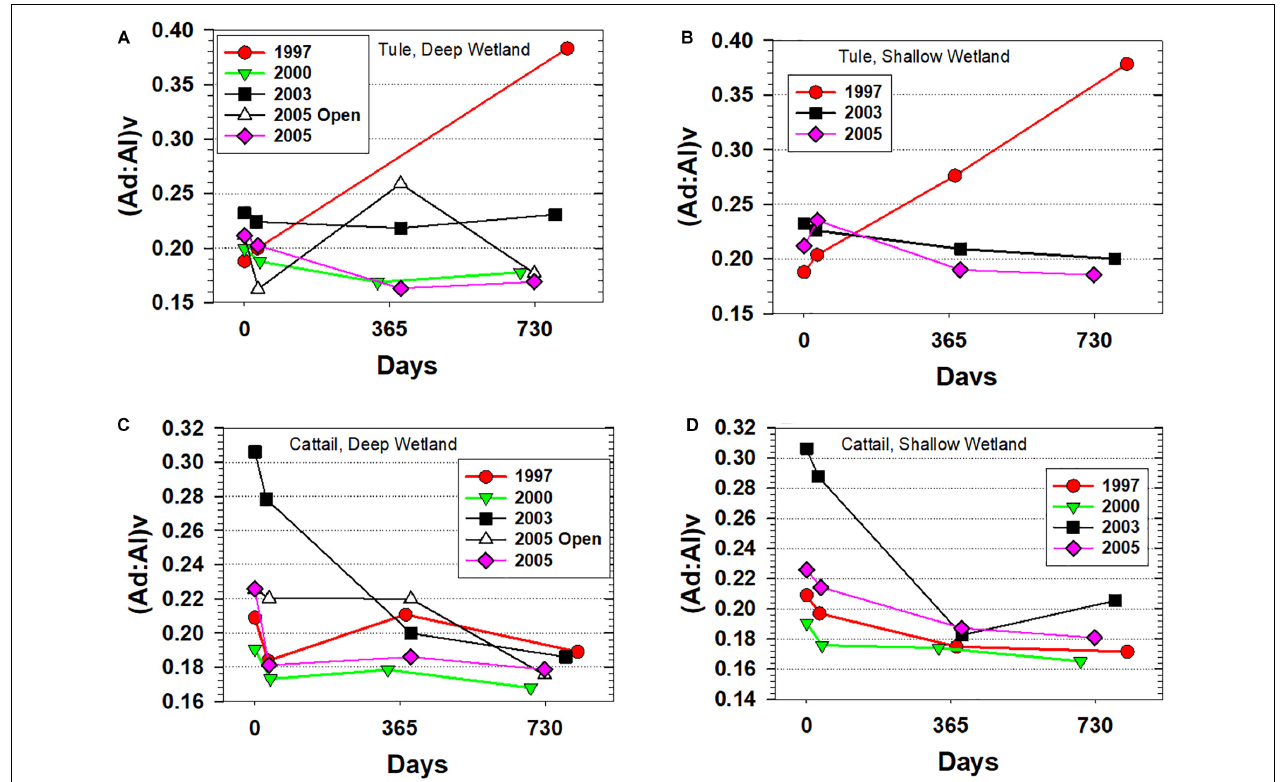
FIGURE 4 | Vanillic acid to vanillin ratios, (Ad:Al) v , for all experiments plotted versus days. (A) Tule litterbags from the Deep wetland, (B) Tule litterbags from the Shallow wetland, (C) Cattail litterbags from the Deep wetland, and (D) Cattail litterbags from the Shallow